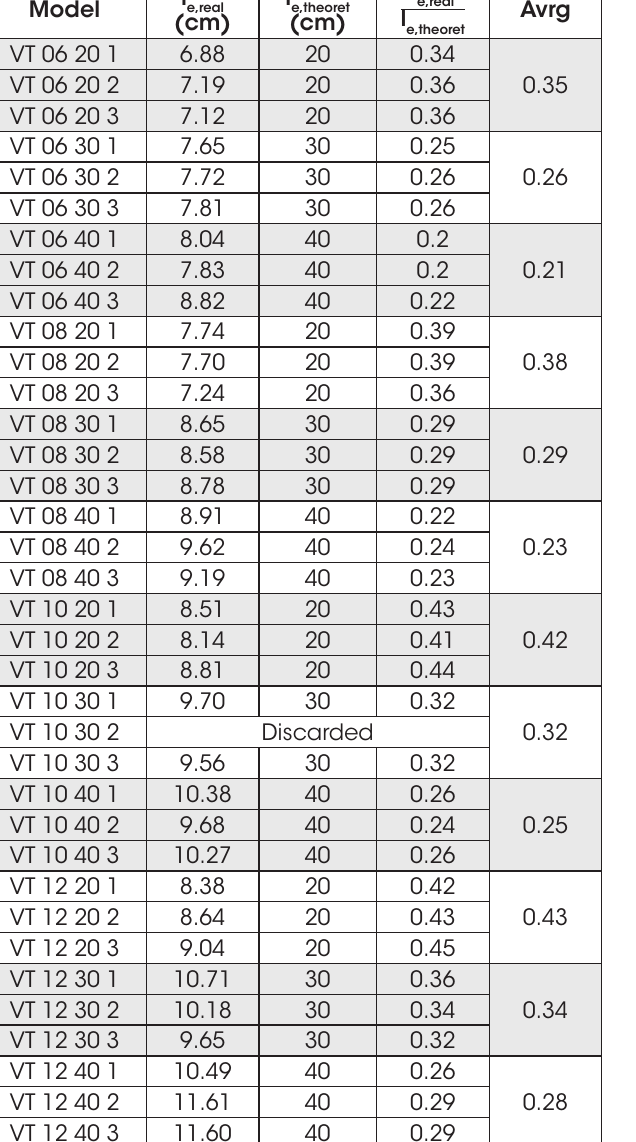
for lattice joists with lower flange buckling failure